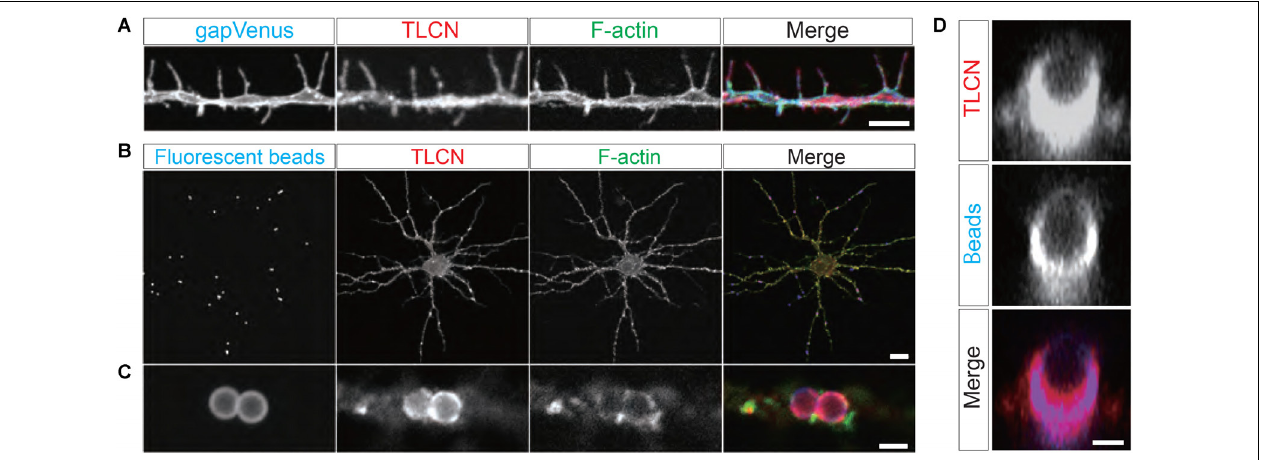
FIGURE 1 | Localization of TLCN in dendritic filopodia and phagocytic cups. (A) Immunofluorescence staining of a dendrite of a cultured hippocampal neuron expressing gapVenus with anti-GFP antibody (blue in a merged image), anti-TLCN antibody (red in a merged image), and phalloidin (green in a merged image). TLCN and F-actin are abundantly observed in dendritic filopodia. (B,C) Formation of phagocytic cup structures on neuronal dendrites. Fluorescent microbeads (blue in merged images of B,C ) added to cultured hippocampal neurons strongly adhere onto dendrites and induce the accumulation of TLCN (red in merged images of B,C ) and F-actin (green in merged images of B,C ). (D) A lateral view of a dendritic phagocytic cup reconstructed from confocal images reveals surrounding of the fluorescent bead (blue in merged images of D ) by TLCN (red in merged images of D ). Scale bars, 1 µ m in (D) , 2 µ m in (A) and (C) , 20 µ m in (B) .